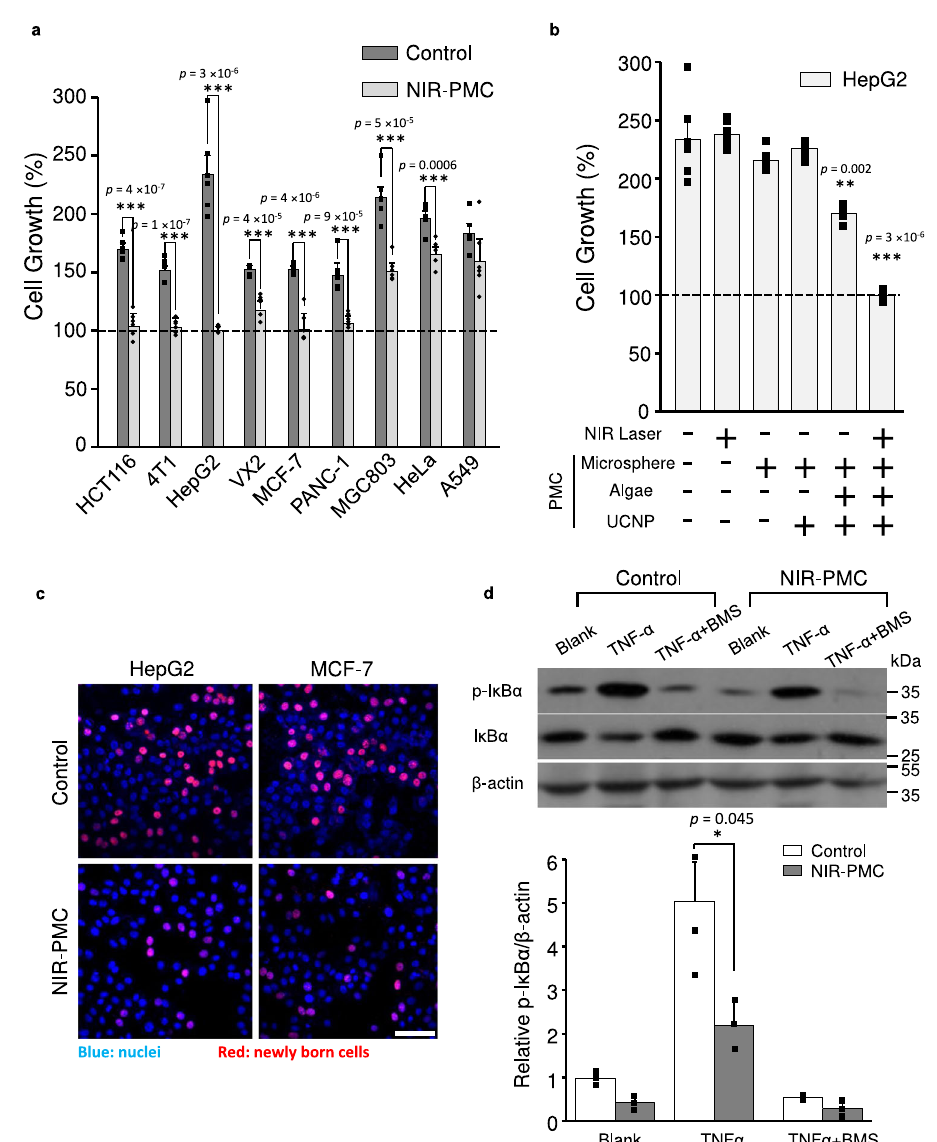
Fig. 3 | Impacts of NIR-PMCs on cancer cell proliferation. a Cell proliferation assessment. HCT116, 4T1, HepG2, VX2, MCF-7, PANC-1, MGC-803, HeLa and